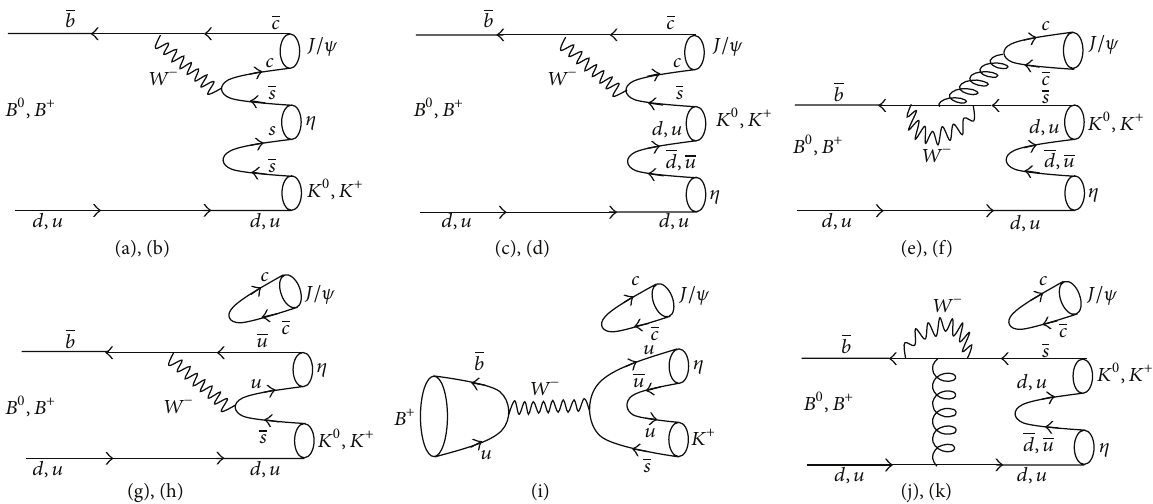
Figure 1: Quark diagrams illustrating the processes 𝐵 0 → 𝐽/𝜓𝜂𝐾 0 and 𝐵 + → 𝐽/𝜓𝜂𝐾 + decay. Panels (a)–(d) show the tree, (e)-(f) show the penguin, (g)-(h) show the emission, and (i)–(k) show the emission-annihilation transitions. The diagrams in which 𝐽/𝜓 is emitted via gluon exchange are called “hairpin”